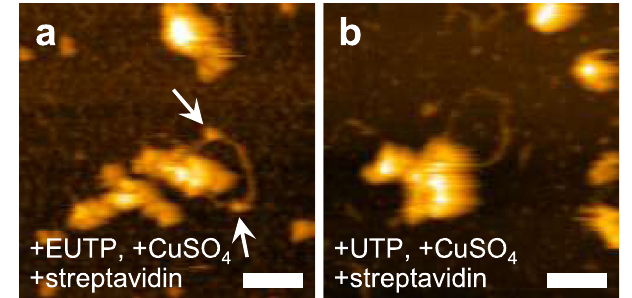
Fig. 5 incorporation of EUTP into looped RNA. a Con fi rmation of the incorporation of EUTP into looped RNA using Click chemistry. Streptavidin molecules binding to looped RNA are indicated by arrows. b Negative control of the Click reaction. The sample was prepared using UTP instead of EUTP. Each of these results was reproduced at least three times. Scale